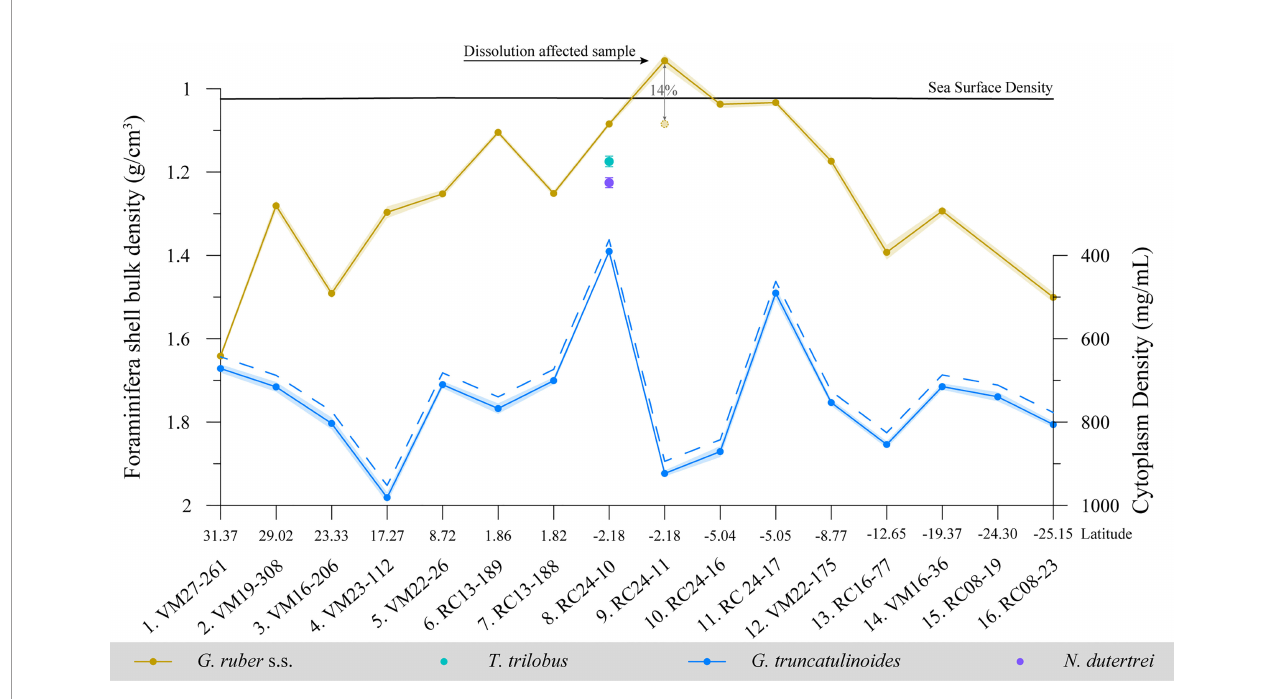
FIGURE 5 | Shell bulk densities of four different foraminifera species. With solid lines are the bulk densities of G. ruber albus and G. truncatulinoides along the transect. The shaded areas depict the 1 s con fi dence interval of the shell bulk density measurements. The secondary y-axis and the dashed lines show the reconstructed average cytoplasmic densities necessary for free fl oating at calci fi cation depth at each site. For sample 8. RC24-10 shell bulk densities were calculated for two additional species. In solid black line the sea surface density (SSD) is shown. The deviation of sample 9. RC24-11 from the SSD may point to test